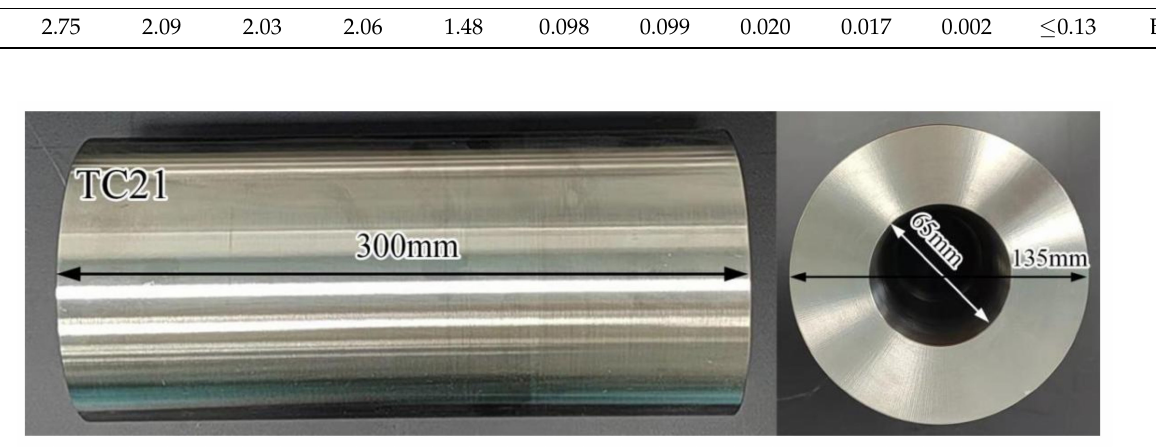
Figure 1. Picture of ring-shaped sample of TC21 titanium